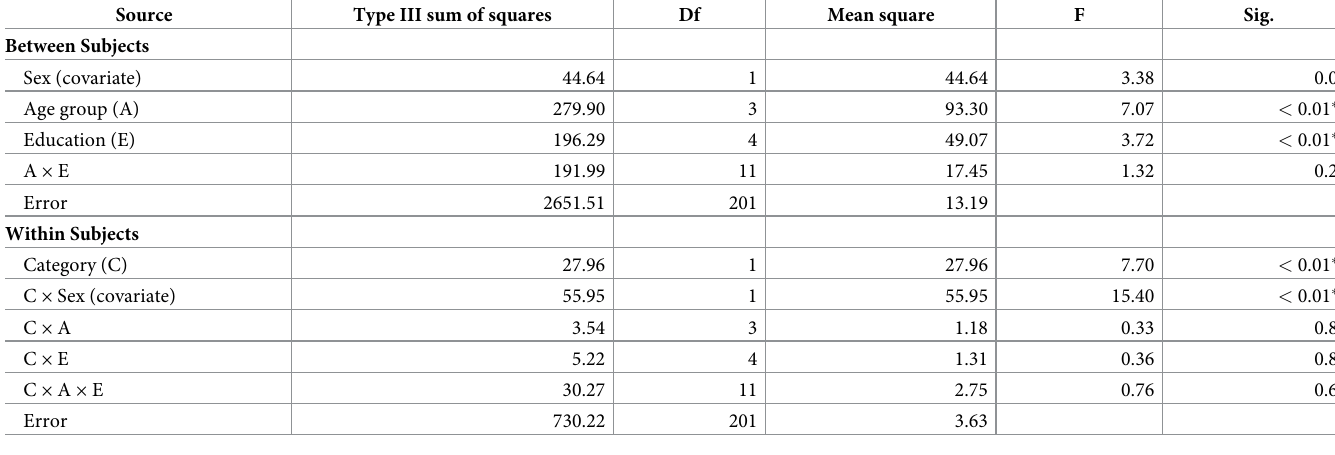
Note. �� indicates p <